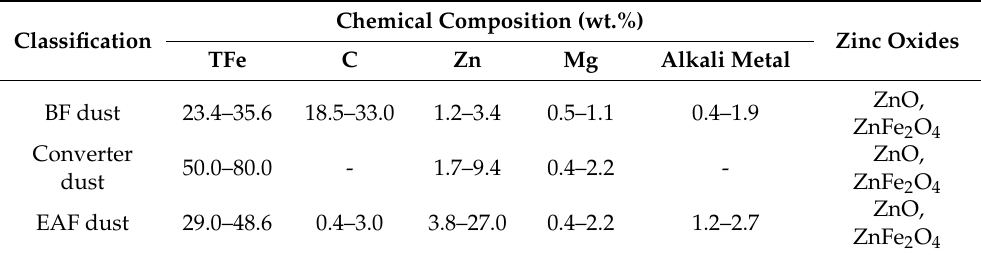
Table 1. Chemical composition of SMD